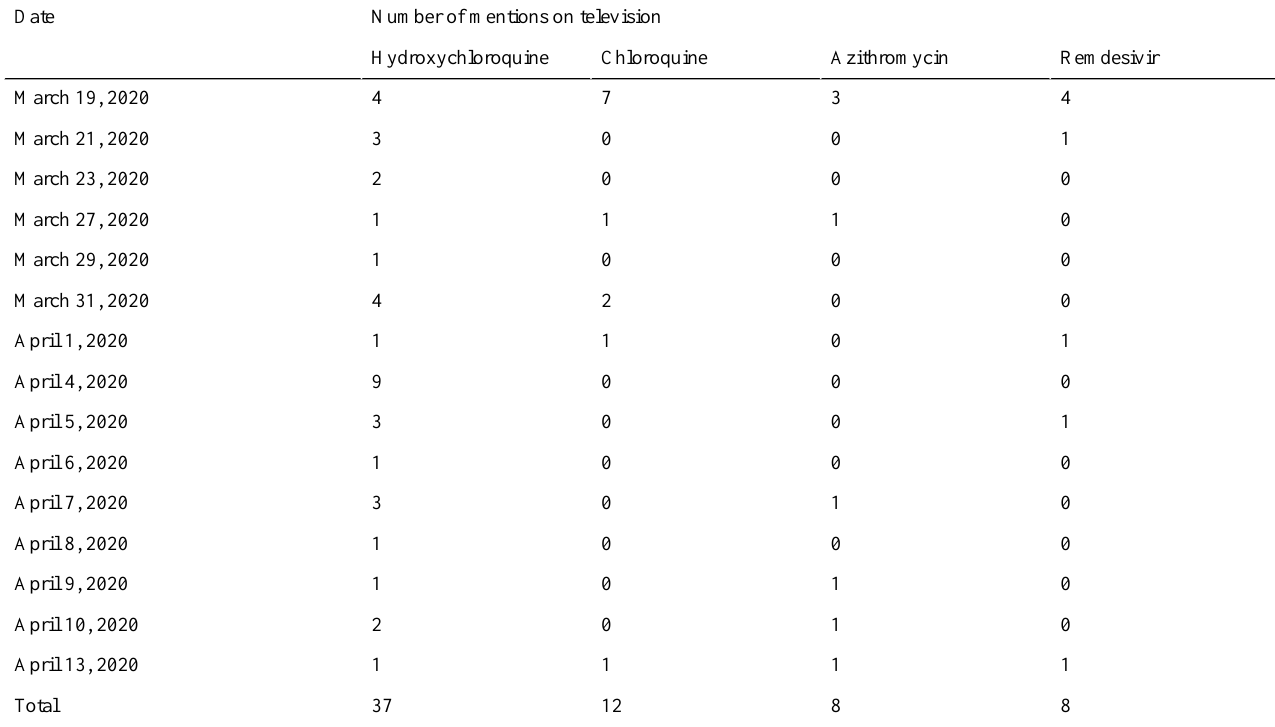
Table 2. Dates of Donald J Trump’s mentions of unproven therapies during televised appearances. Number of mentions on televisionDate